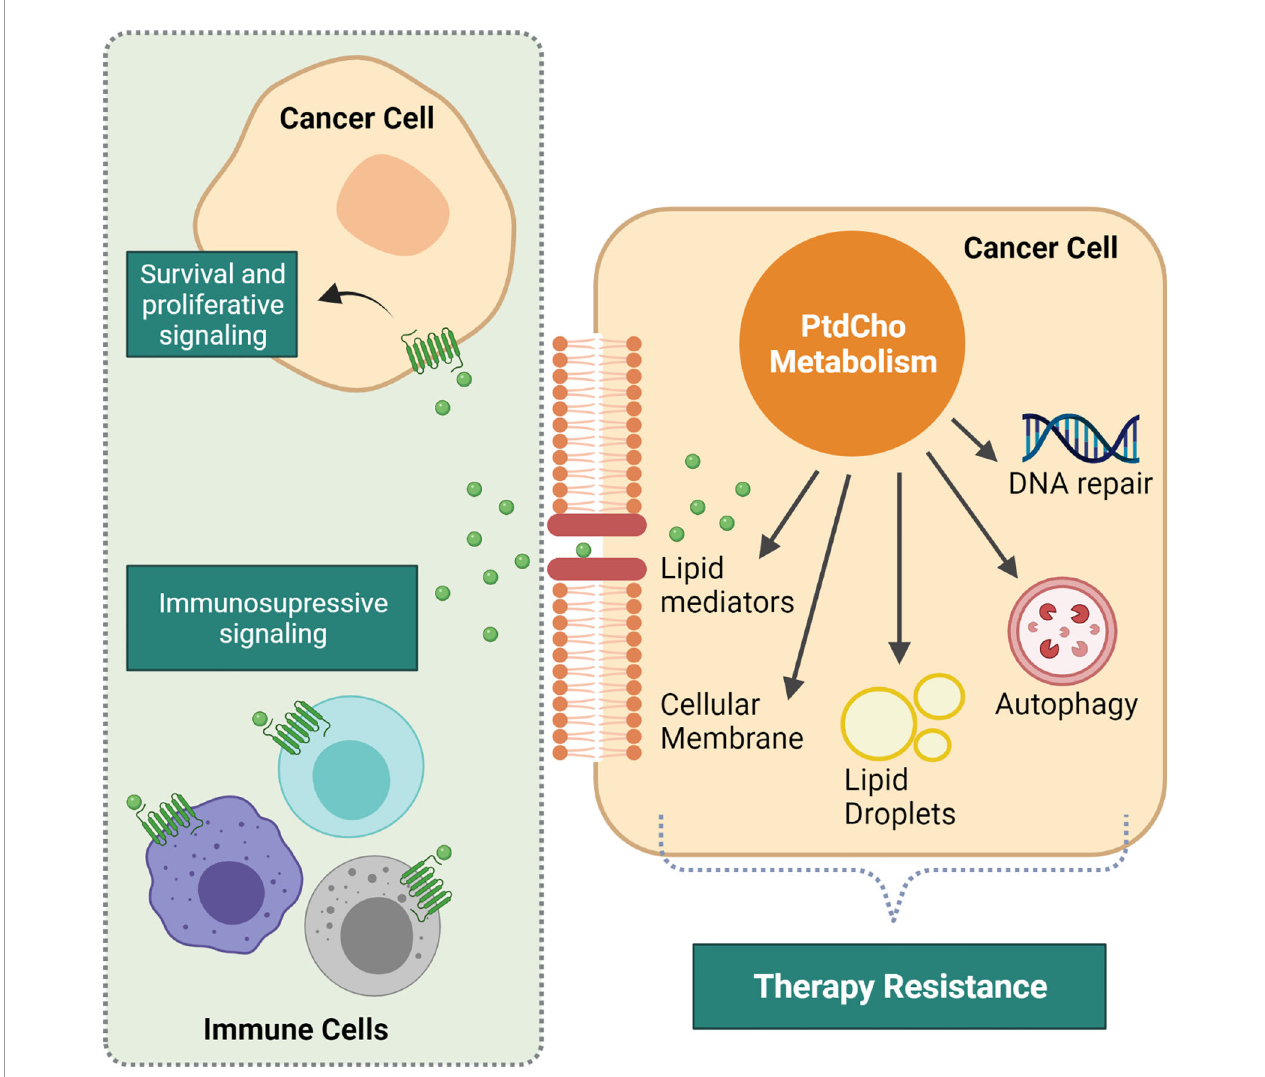
FIGURE 1 | Intracellular and intercellular consequences of altered phosphatidylcholine (PtdCho) metabolism that impacts response to therapy. Increased PtdCho metabolism supports cancer cell accelerated growth by providing the major cellular membrane component. Additionally, PtdCho promotes intracellular events that mediate resistance to therapy, such as DNA repair, lipid droplet synthesis, and autophagy process. PtdCho-derived lipid mediators are prominent drivers of resistance. They are recognized by their cognate receptors present both in cancer cells and immune microenvironment cells, driving cancer cell survival and proliferation and promoting immunosuppression. Created with